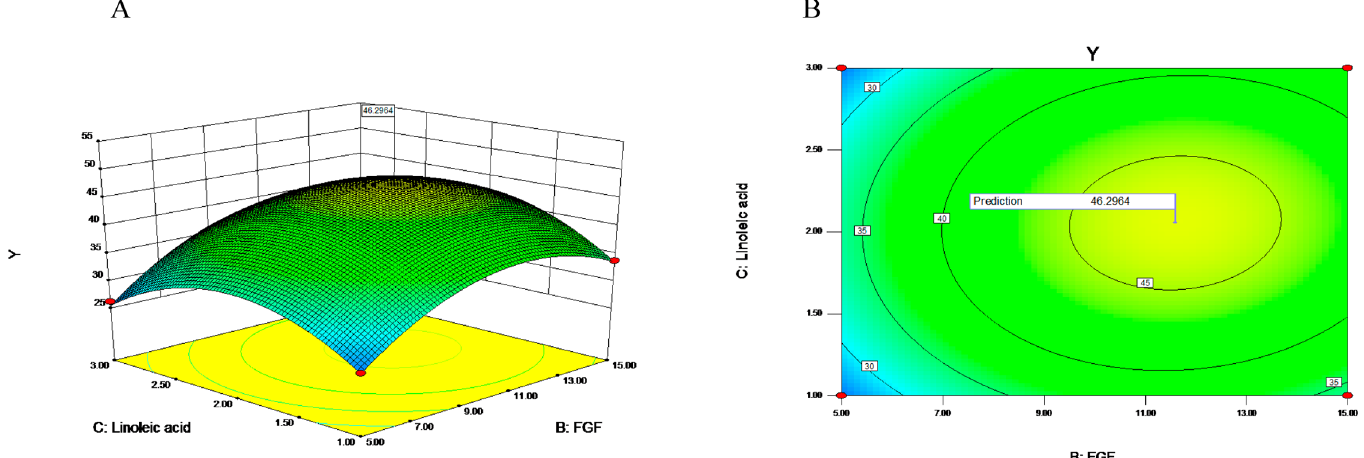
Fig 6. Response surfaceplot of the regression equation (linoleic acid, FGF). The three-dimensional response surface plots (A) and contour charts (B) were used to illustrate the individualand interactive effects of FGF and linoleicacid.